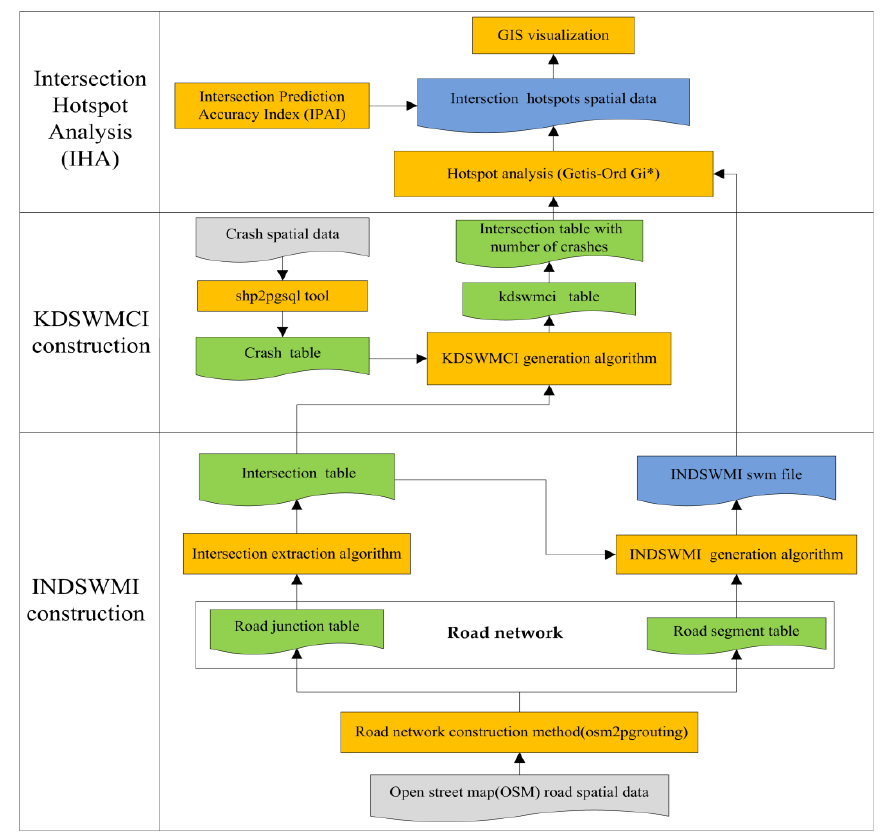
Figure 1. A process map for the identification approach to detect crash hotspot intersections (CHIs).